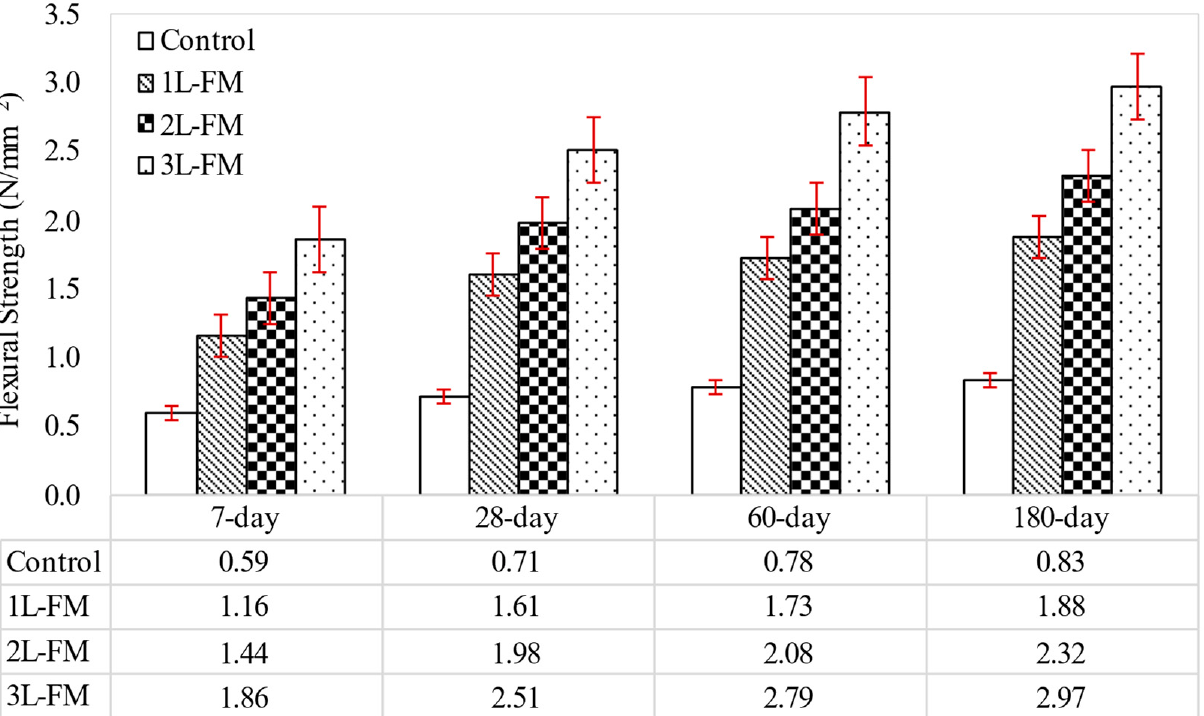
Figure 8. Flexural strength of foamcrete with different layers of FM.